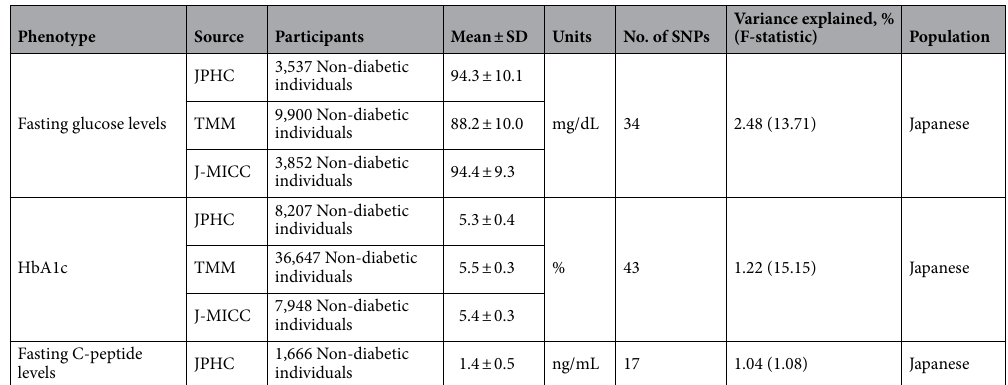
Table S5 For fasting glucose and HbA1c, we meta-analysed each β coefficient and its 95% confidence interval (CI) from the individual study and further meta-analysed the overall effects of SNP-exposure in the fixed-effects inverse-variance weighted (IVW) method. Fasting glucose (mg/dL) and HbA1c (%) were unchanged. Fasting C-peptide (ng/mL) was log-transformed to enhance compliance with normality. Genetic associations with colorectal cancer.